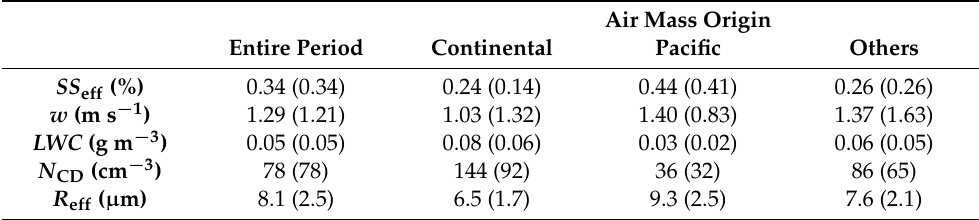
Figure 8. Relationship between N CD and N CCN under 0.21% SS. Table 3. Mean values of SS eff , w , N CD , LWC and R eff for clouds at the MFRS classified according to air mass origin. Standard deviations are indicated in